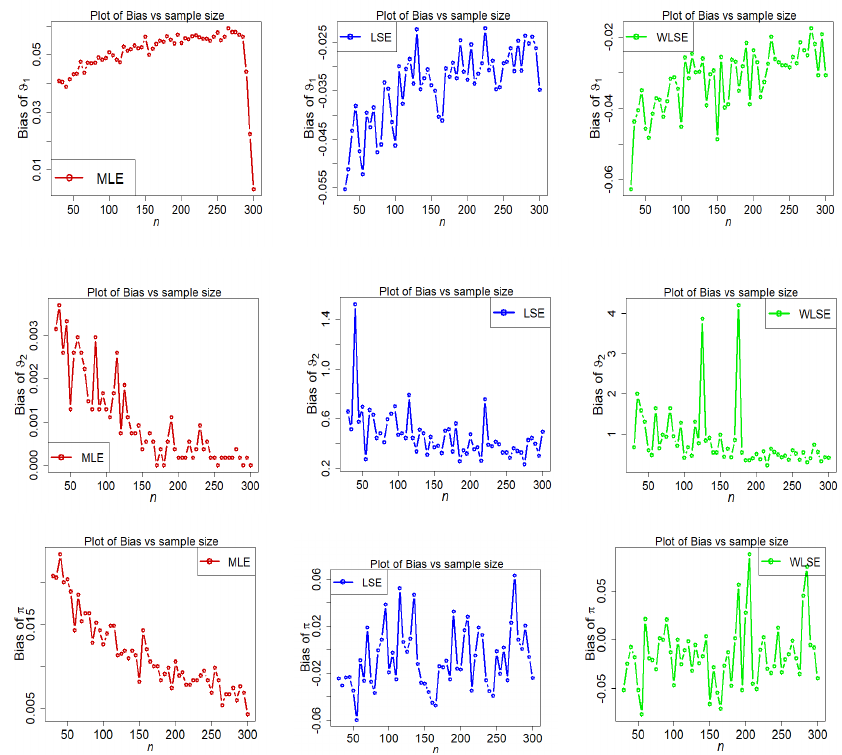
Figure 13. Fluctuations of bias of estimators under different methods for parametric set IV.